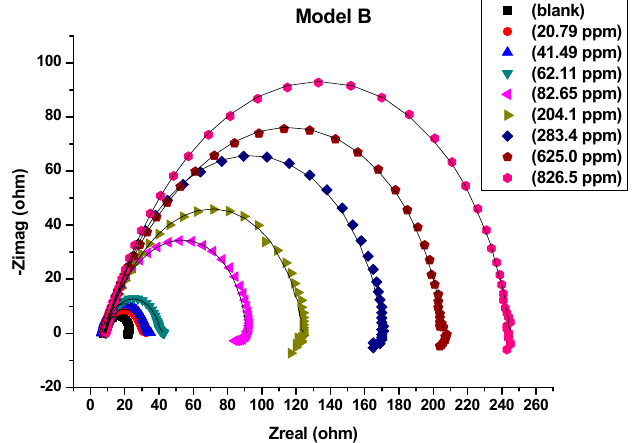
Figure 6. Nyquist plots in 0.25 M H 2 SO 4 , fitted by equivalent circuit model B for all concentrations of Harmal extract (0, 20.79, 41.49, 62.11, 82.65, 204.1, 283.4, 625.0 and 826.5 ppm). tration from 82.65 ppm to 826.5 ppm. Thus, equivalent electrical circuit model B with two time constants was used, (Figure 6). It gave a better fitting of impedance data for all range of concentration including the blank solution, Table 2. In general, each electrochemical process in the circuit should be represented by a separate distinct semicircle in the Nyquist plot. But when their capacitive nature has short time to relax during the change in the boundary conditions, overlapped arcs are observed in the EIS. Also, due to the high frequency limit, the first semicircle is difficult to see [6,55,56]. This result indicates that the simple prediction of the number of the time constant of the impedance spectrum from the number of capacitive loops in Nyquist plots is inadequate [57]. The fitted model B consists of two circuits connected in series and contains solution resistance ( R s ), film resistance ( R f ), charge ‐ transfer resistance ( R ct ), constant phase element of the film (CPE f ) and of the double layer (CPE dl ). The double layer capacitance ( C dl ) can be also calculated from the values of R ct , the impedance of CPE dl (Z CPE ), and the exponents of CPE dl (n) [58]. R f or coating resistance ( R c ) is often used for an intact film/coat which act as an isolation layer and provide a good protective performance [59]. Table 2. Impedance parameters for Harmal extract on C ‐ steel in 0.25 M H 2 SO 4 medium by fitting the equivalent circuit model B. Figure 7. Nyquist plots in 0.25 M H 2 SO 4 , fitted by equivalent circuit model C for all concentrations of Harmal extract (0, 20.79, 41.49, 62.11, 82.65, 204.1, 283.4, 625.0 and 826.5 ppm). The increase in R ct and decrease in CPE impedance values upon addition of Harmal extract indicated reduction in the corrosion rate with increase in electrical double layer thickness due to the formation of adsorbed protective film on the metal ‐ solution interface. The inhibition action suppresses both the impedance Z CPE and corrosion current density ( i corr ) due to replacement of water molecules present on the surface of steel electrode sur ‐ face by the inhibitor ones [52], Tables 1–3. Table 3. Impedance parameters for Harmal extract on C ‐ steel in 0.25 M H 2 SO 4 medium by fitting the equivalent circuit Model C. Harmal Extract ppm